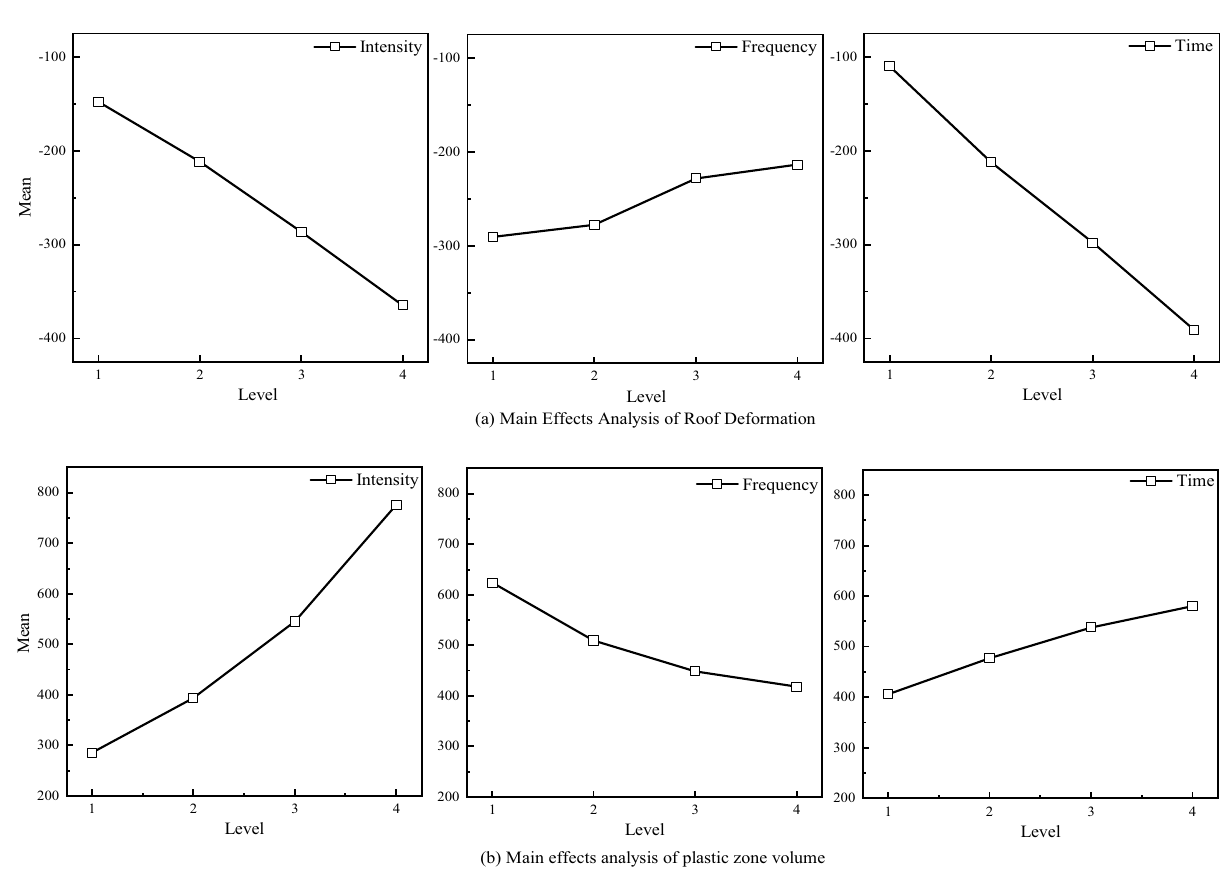
Figure 18. Main effect diagram of deformation and failure of surrounding